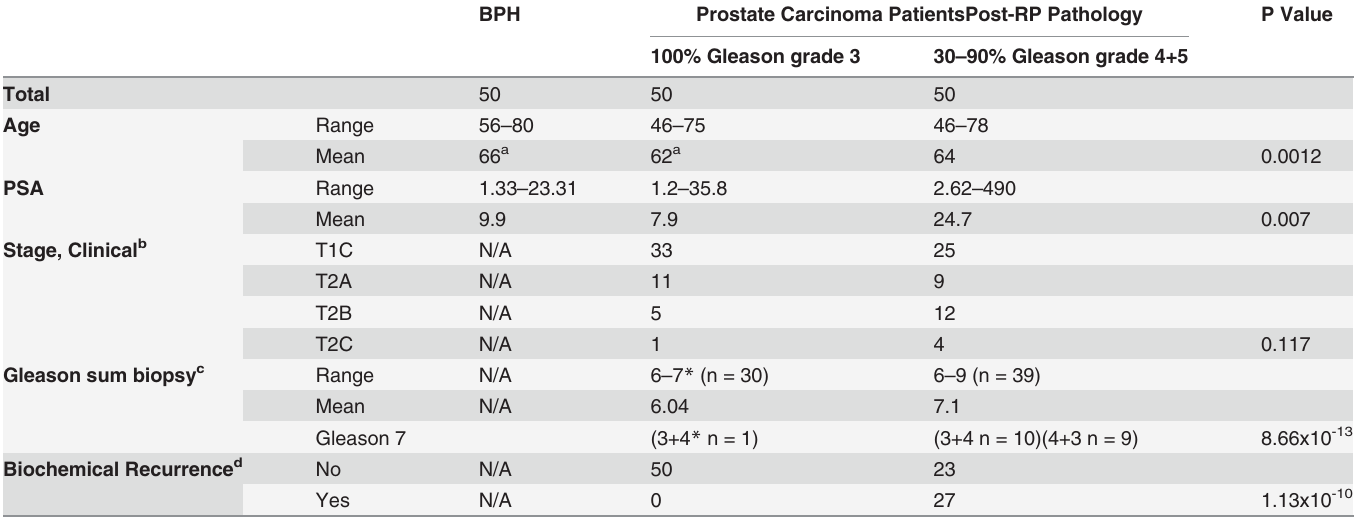
Table 1. Patient